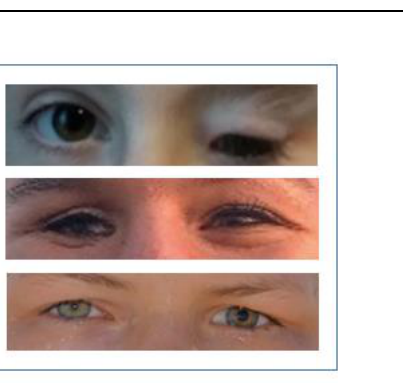
Figure 3. Patients after more than 10 years of treatment or monitoring by doctors and ocularists. Top: anophthalmos (left), middle: anophthalmos (right), bottom: microphthalmos